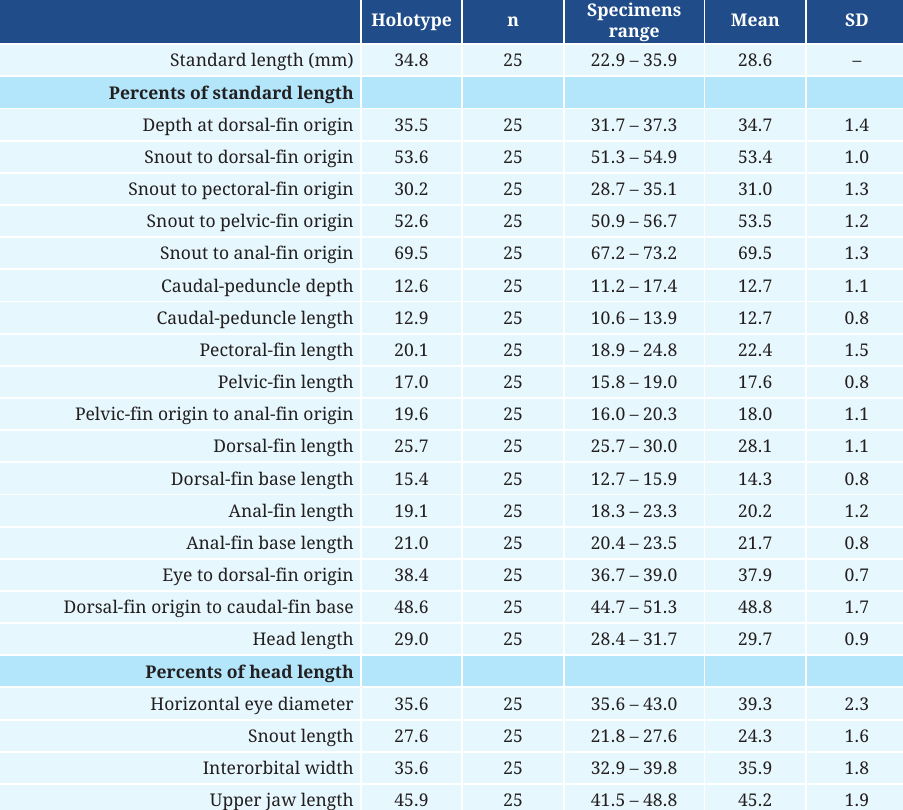
TABLE 1 | Morphometric data of Moenkhausia cambacica . Range includes the holotype. SD = Standard